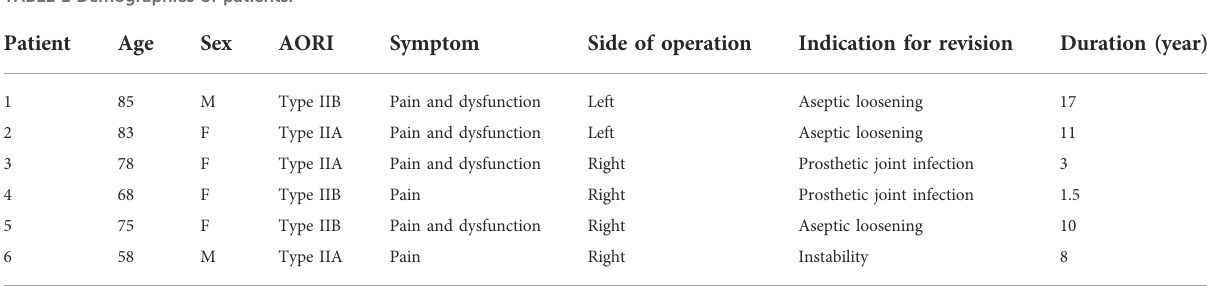
TABLE 1 Demographics of patients.